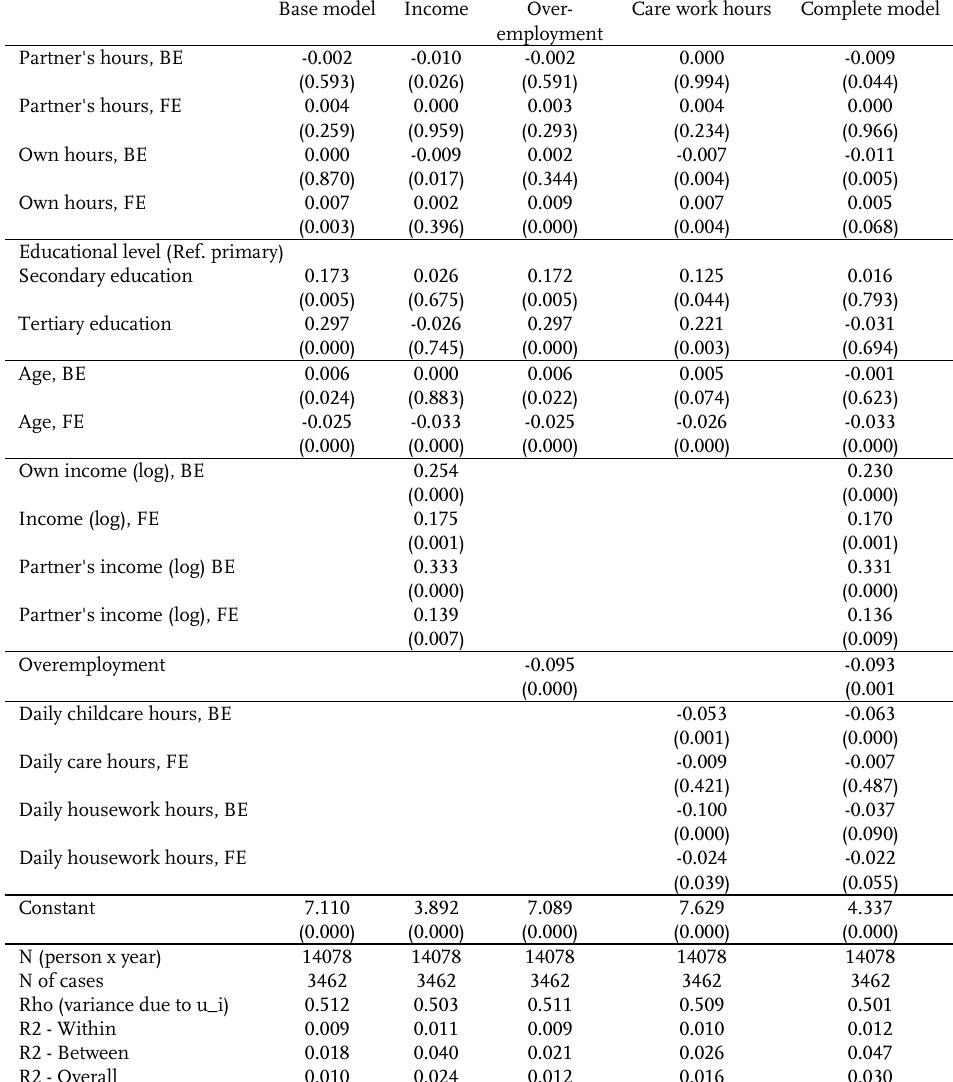
Table A.4 : Estimated coefficients of the Hybrid model: Women without children < 14 in the household; p values in parentheses Base model Income Over- Care work hours Complete employment